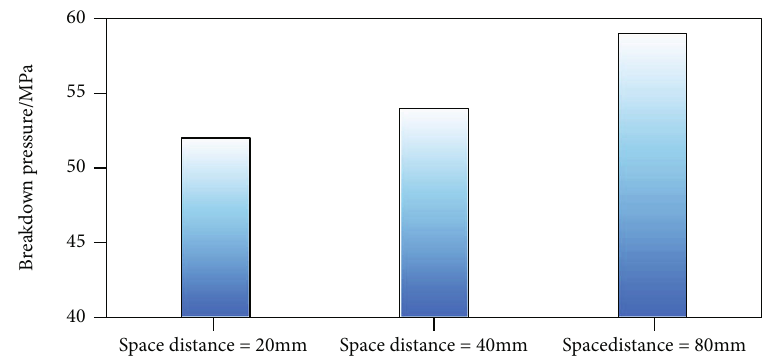
Figure 18: Breakdown pressure with di ff erent development densities of bedding